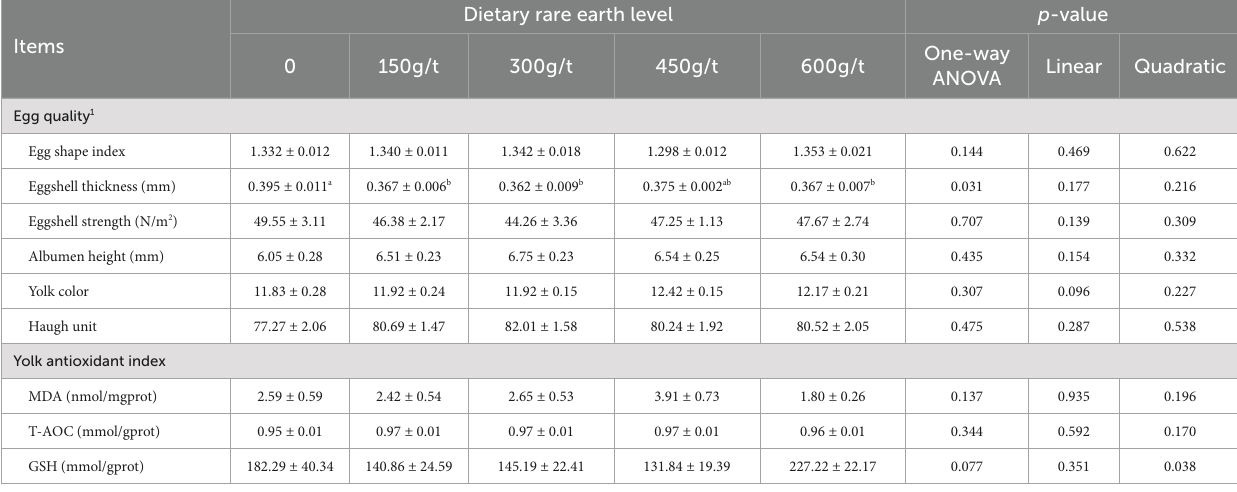
TABLE 3 Effects of dietary rare earth supplementation on egg quality and yolk antioxidant index in laying hens during the late laying stage ( n = 6).